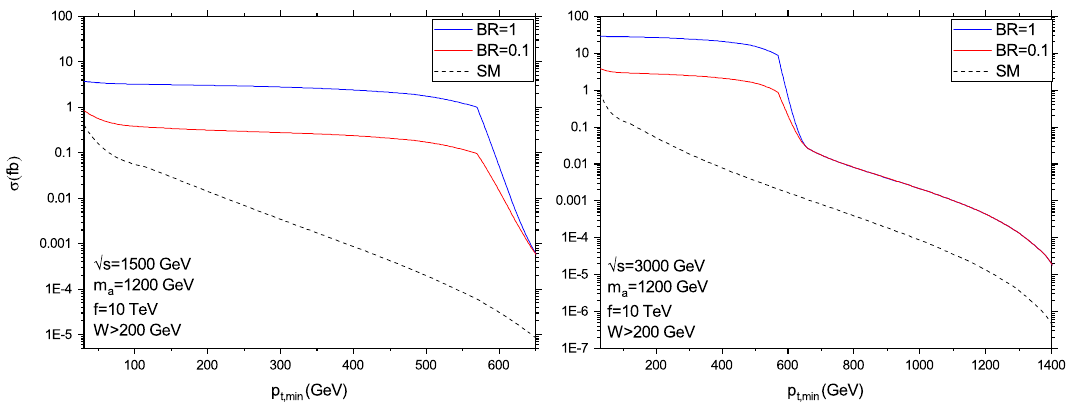
Figure 10 . The same as in figure 9, but for the total cross sections as functions of the transverse momenta cutoff p t , min of the final photons.